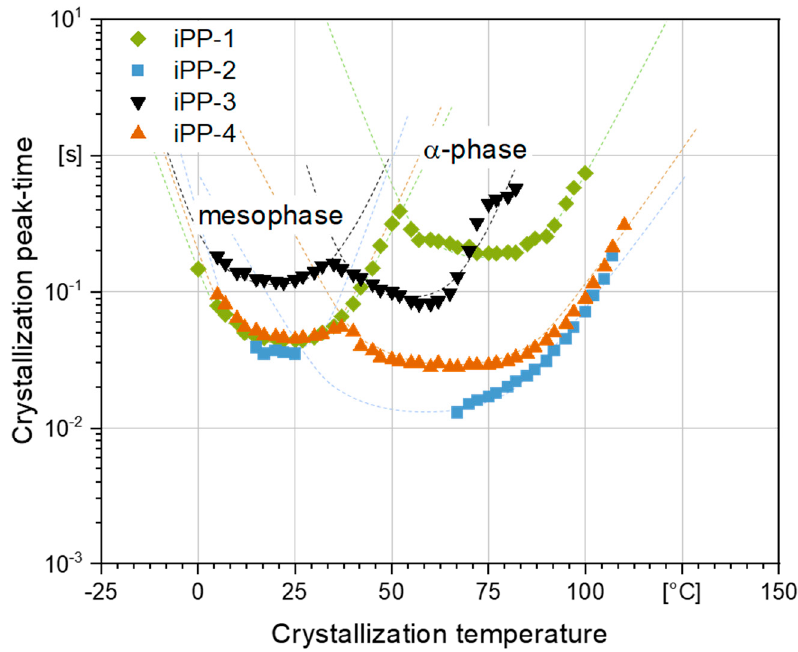
Figure 7. Isothermal crystallization peak-time depending on the crystallization temperature deter- mined from the isothermal crystallization curves.